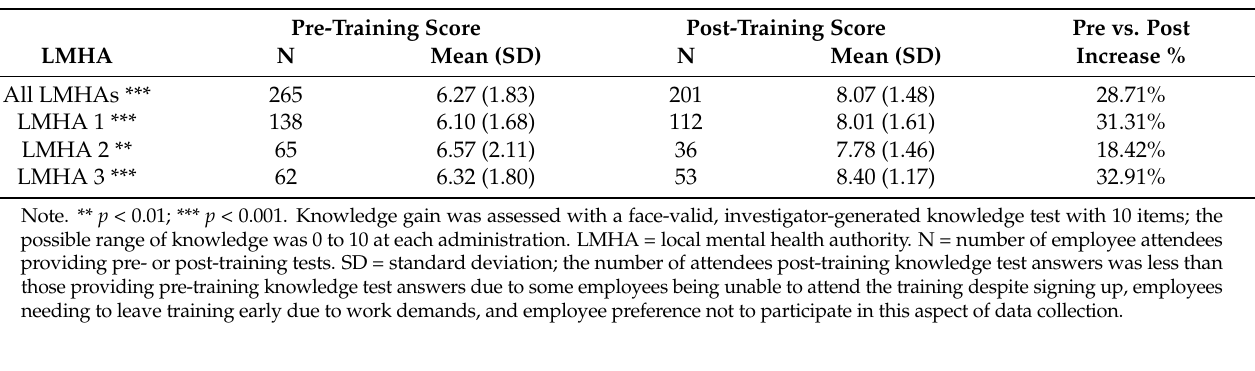
Table 4. Knowledge Increase among Attending Employees of the Champion-delivered